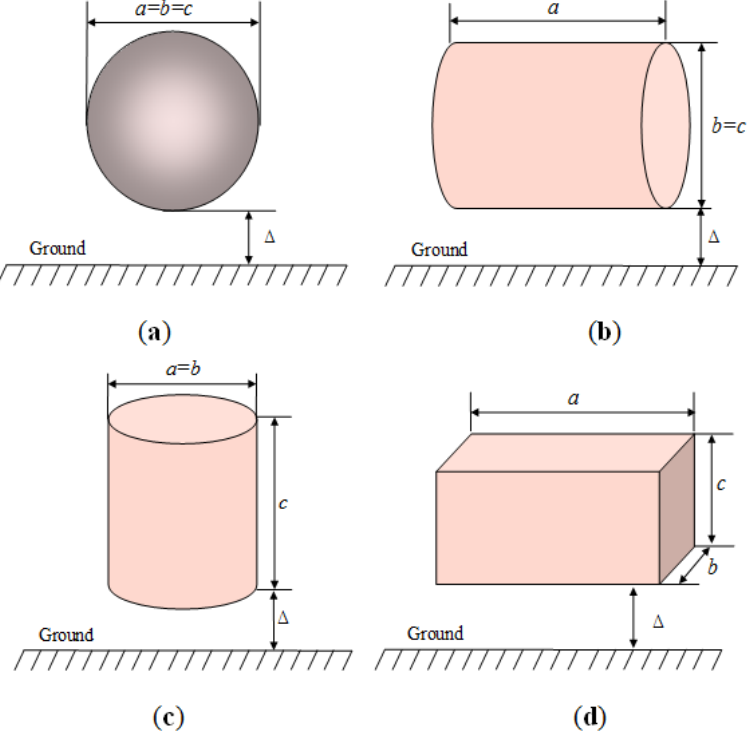
Figure 5. The parameters of a , b and c corresponding to the objects with different configurations, which include ( a ) sphere; ( b ) horizontal cylinders; ( c ) vertical cylinders; and ( d ) rectangular